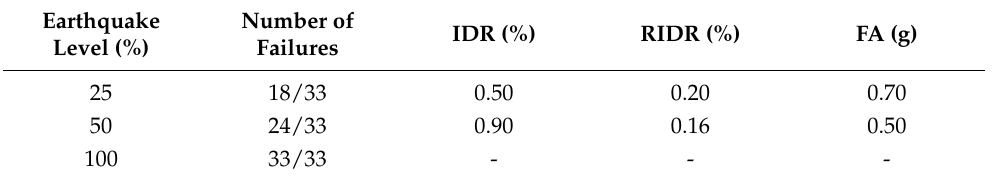
Table 8. Number of failures and peak IDR, RDIR, FA values (no seesaw, flexural and shear hinges). Earthquake